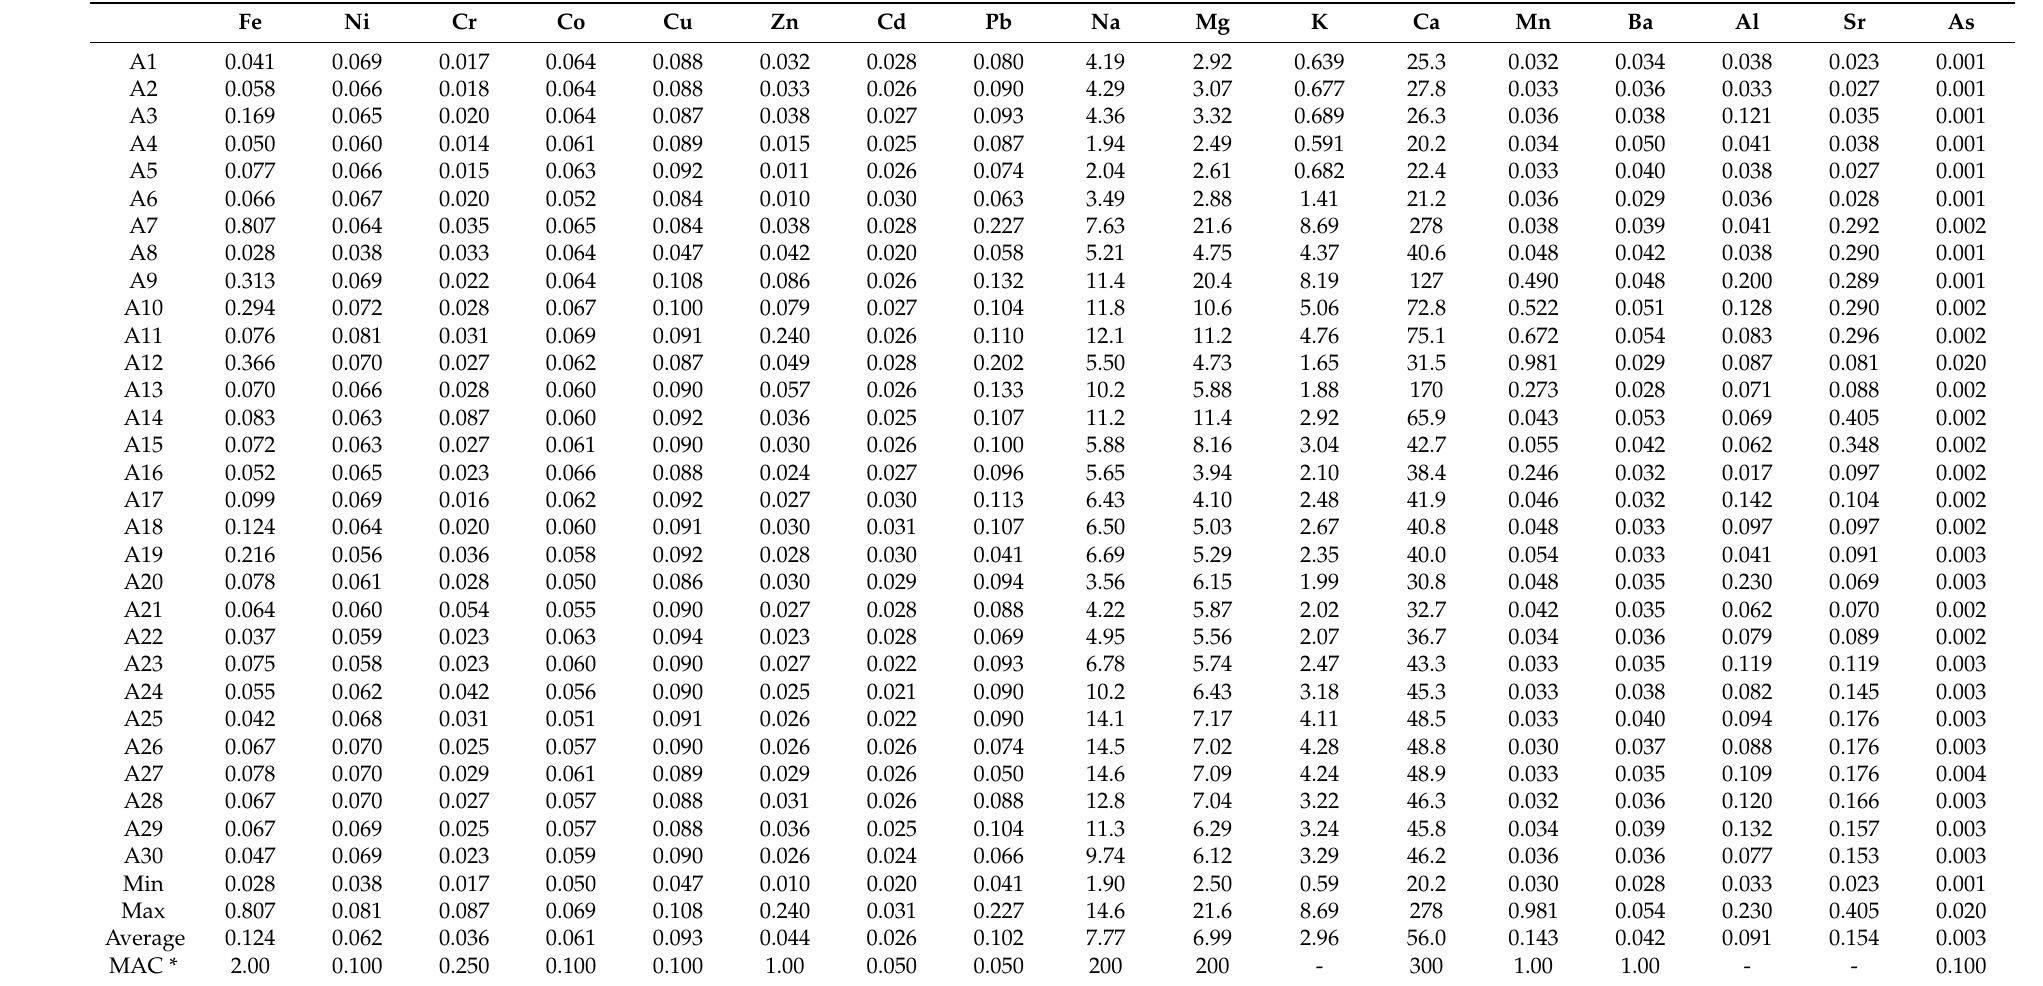
Table 4. The element concentrations (mg/ L) in the surface water samples